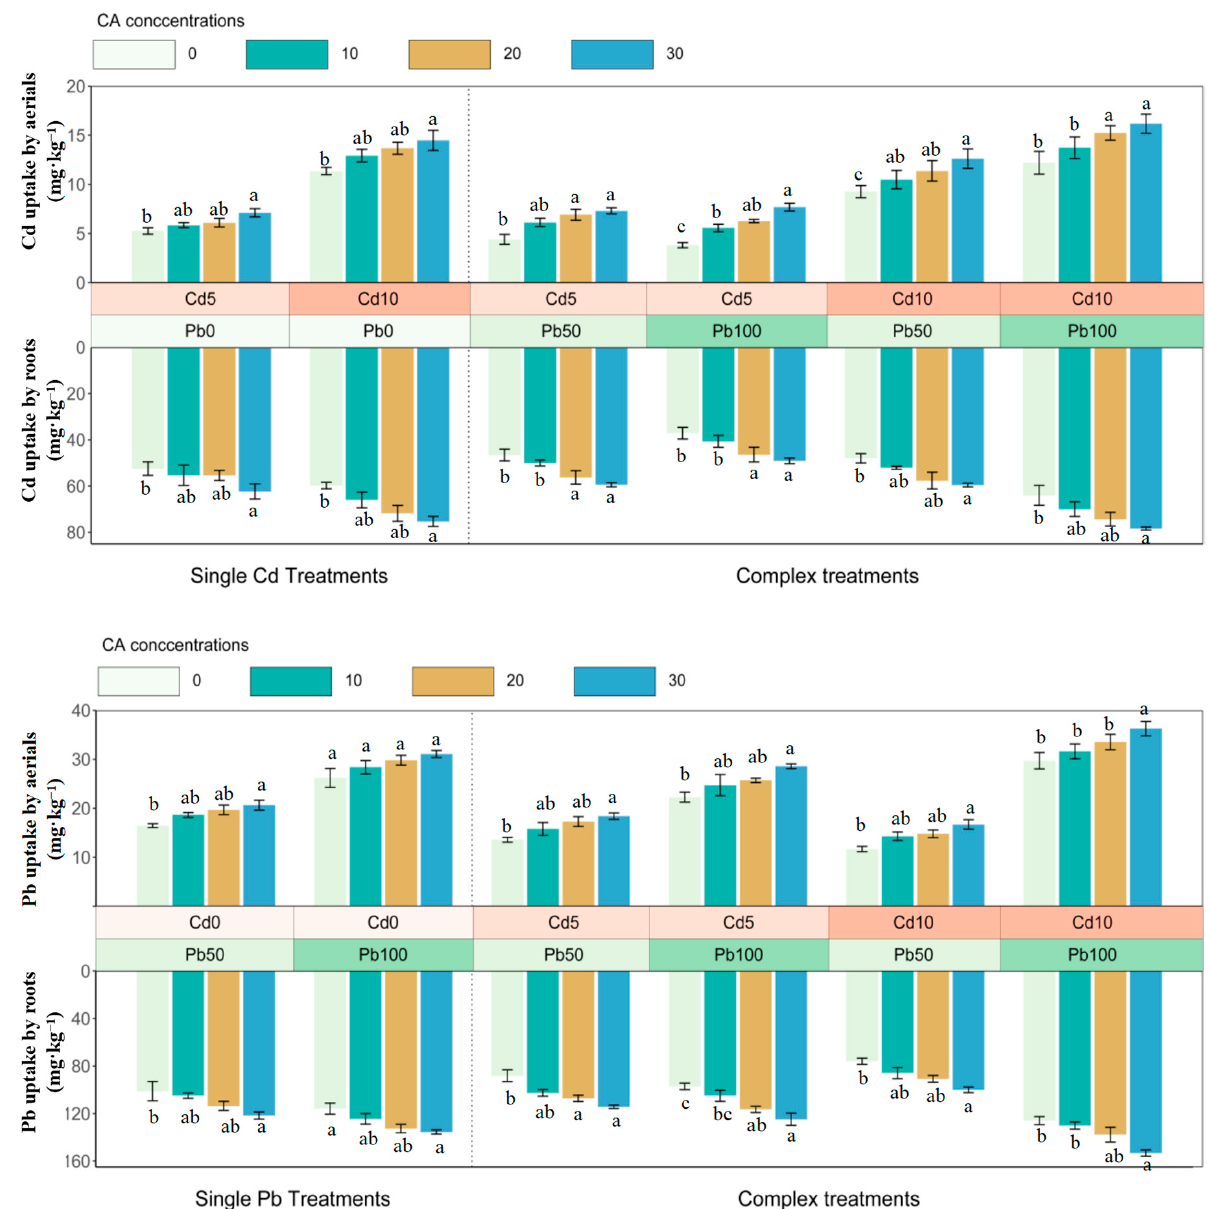
Figure 2. Cd and Pb accumulation in aerials and roots of sunflower in CA treatments after 45 days. CA, citric acid. Bars with different letters indicate significant difference at p < 0.05. Error bars represent ± SE.